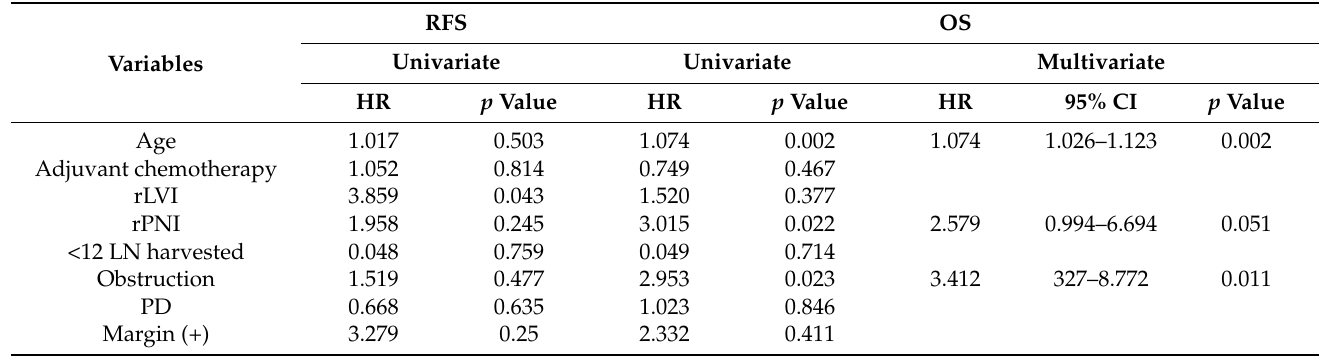
Figure 4. RFS according to the administration of adjuvant chemotherapy in patients with ( A ) rLVI and ( B ) rPNI in the review cohort. The RFS rate did not improve through the addition of adjuvant chemotherapy adj CTx; adjuvant chemotherapy; RFS, recurrence-free survival. The rLVI was the only factor associated with RFS in the univariate analysis ( p = 0.043). In the review cohort, age, rPNI, and preoperative obstruction were found to be risk factors related to a lower OS. For both RFS and OS rates, adjuvant chemotherapy was not found to be an associated factor (Table 5). Table 5. Factors associated with RFS and OS in the review